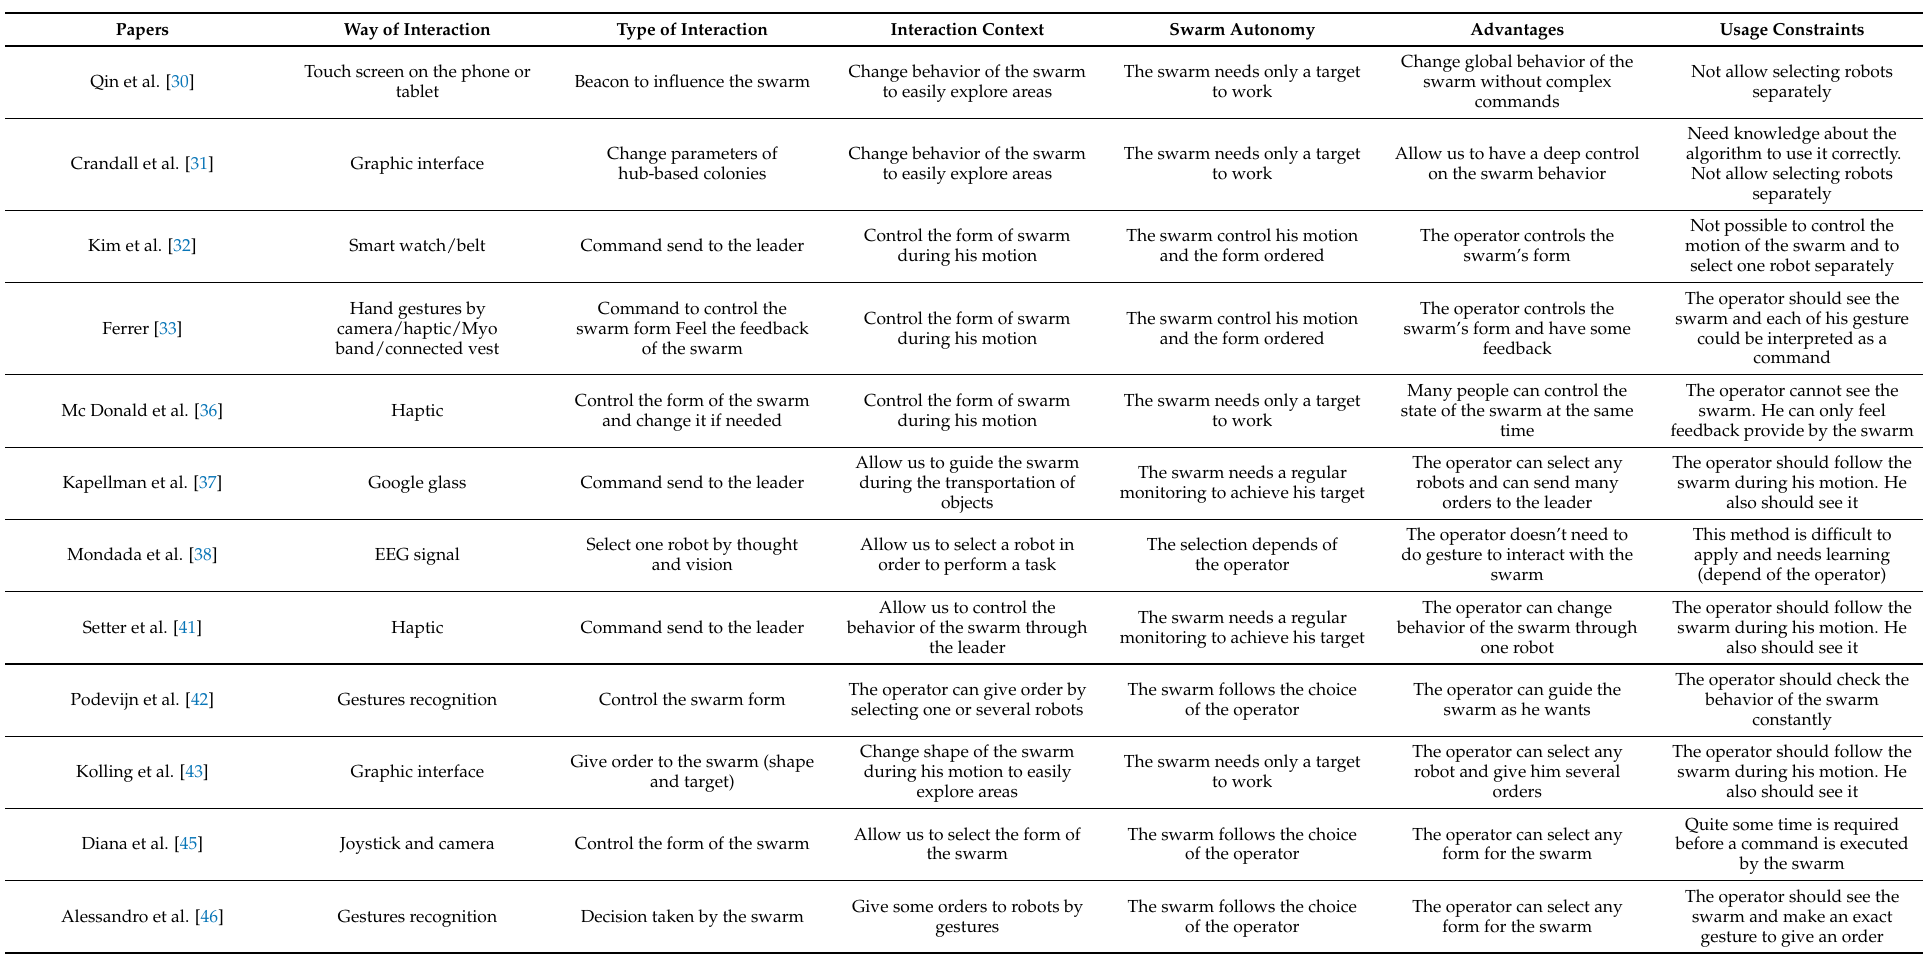
Table 1. Summary of the various supports of